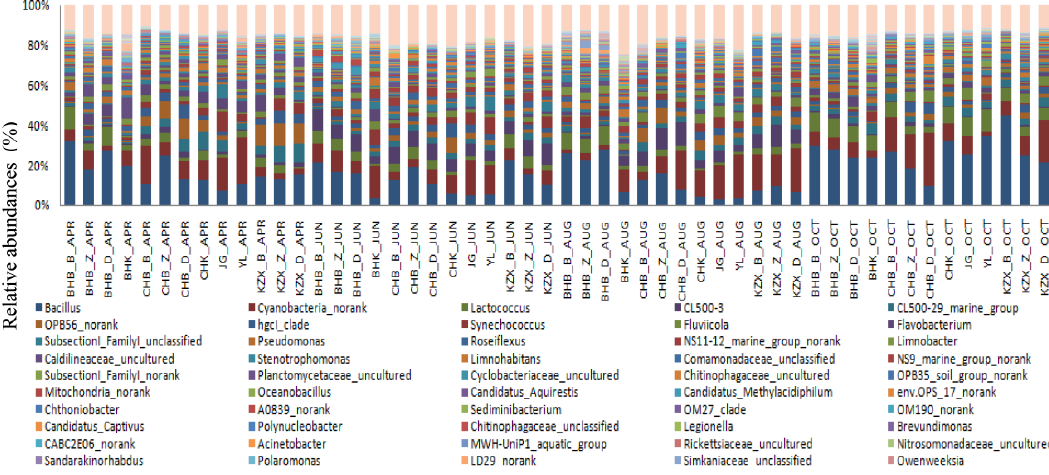
Figure 5. Genus-level changes of the bacterial sequences in different month–site assemblages.